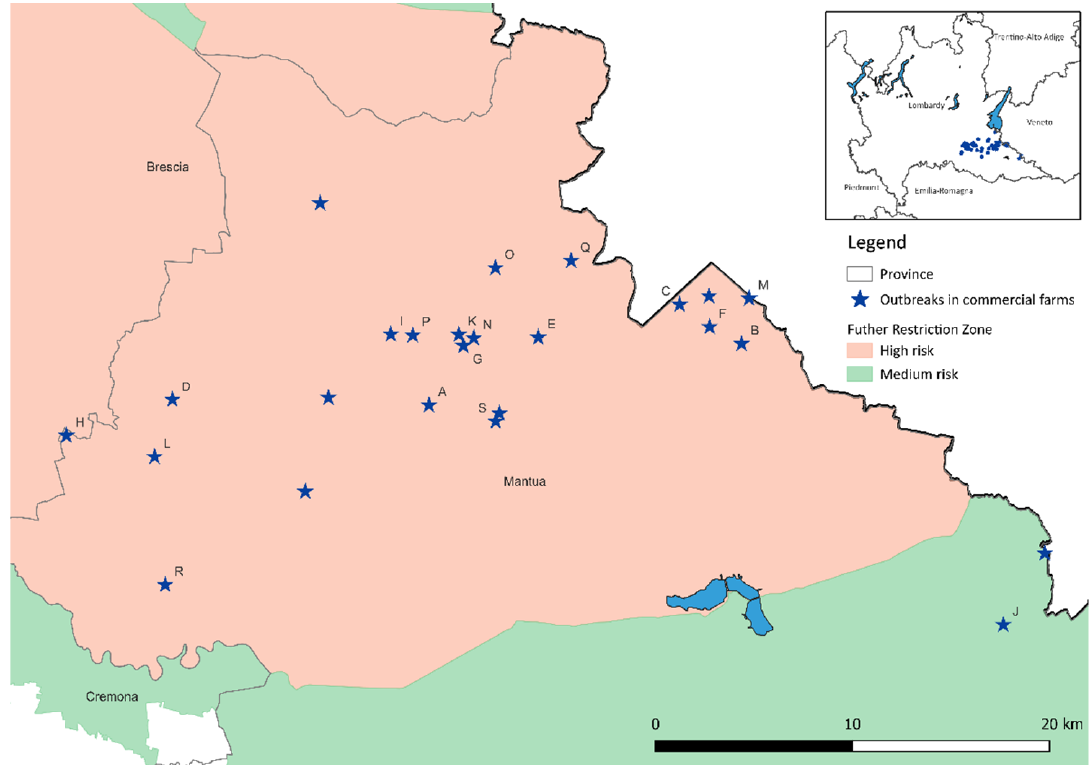
Figure 4. Map of high-risk contact between the HPAI outbreak sites in the province of Mantua.